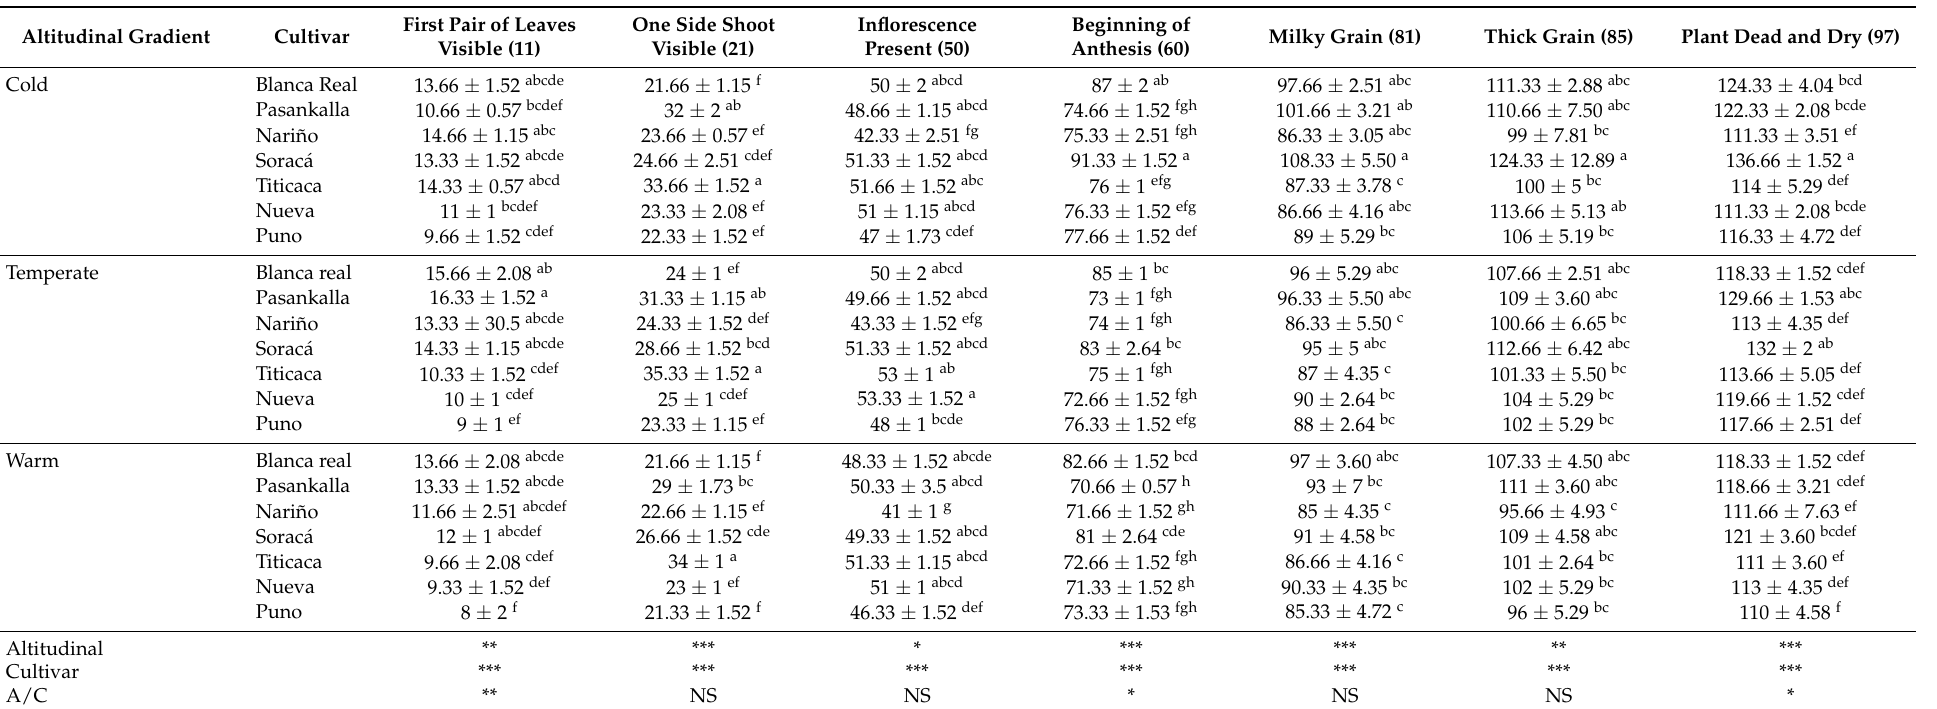
Table 2. Phenological performance of seven quinoa cultivars under three altitude gradients (days after planting). Altitudinal